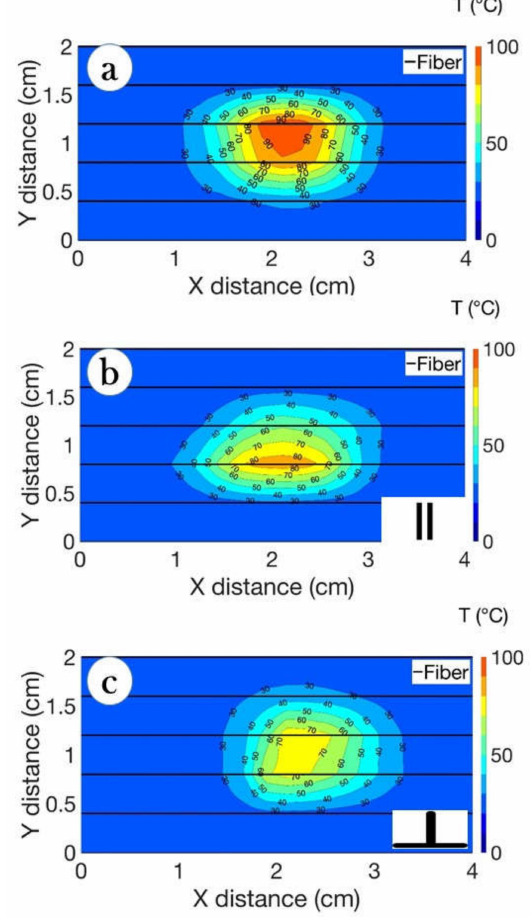
Figure 9. Thermal maps illustrate the temperature difference between cases: ( a ) pristine tissue without vessel placement; ( b ) tissue injected with agarose gel and vessel located in parallel to optical fibers; ( c ) tissue injected with agarose and vessel located in perpendicular to the optical fibers. The displayed maps report the temperature distribution observed for the ablation peak.